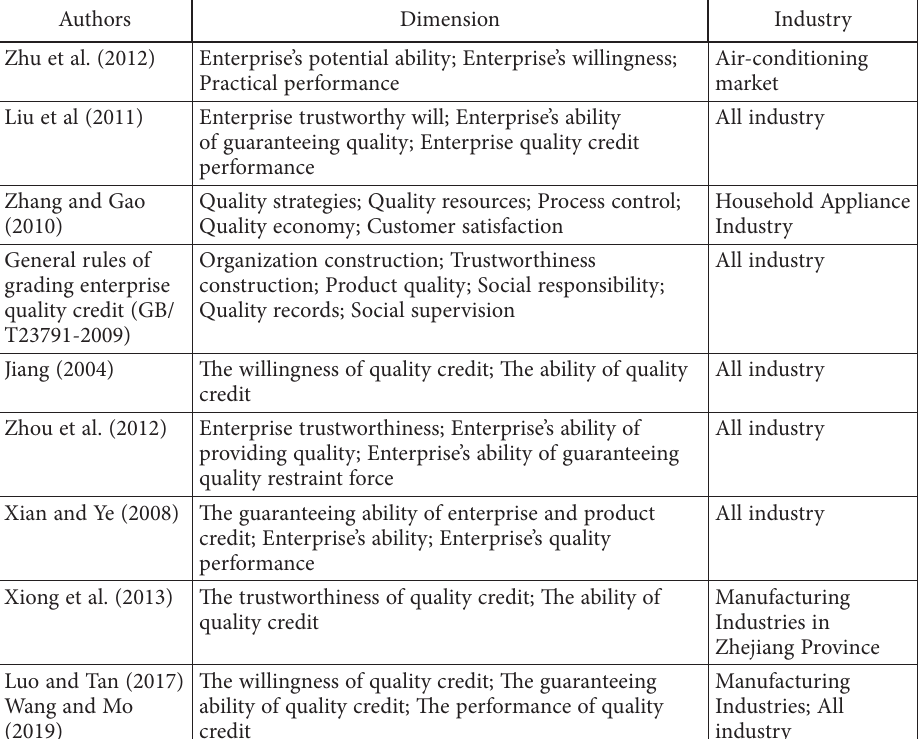
Table 2. Dimensions of quality credit considered in the